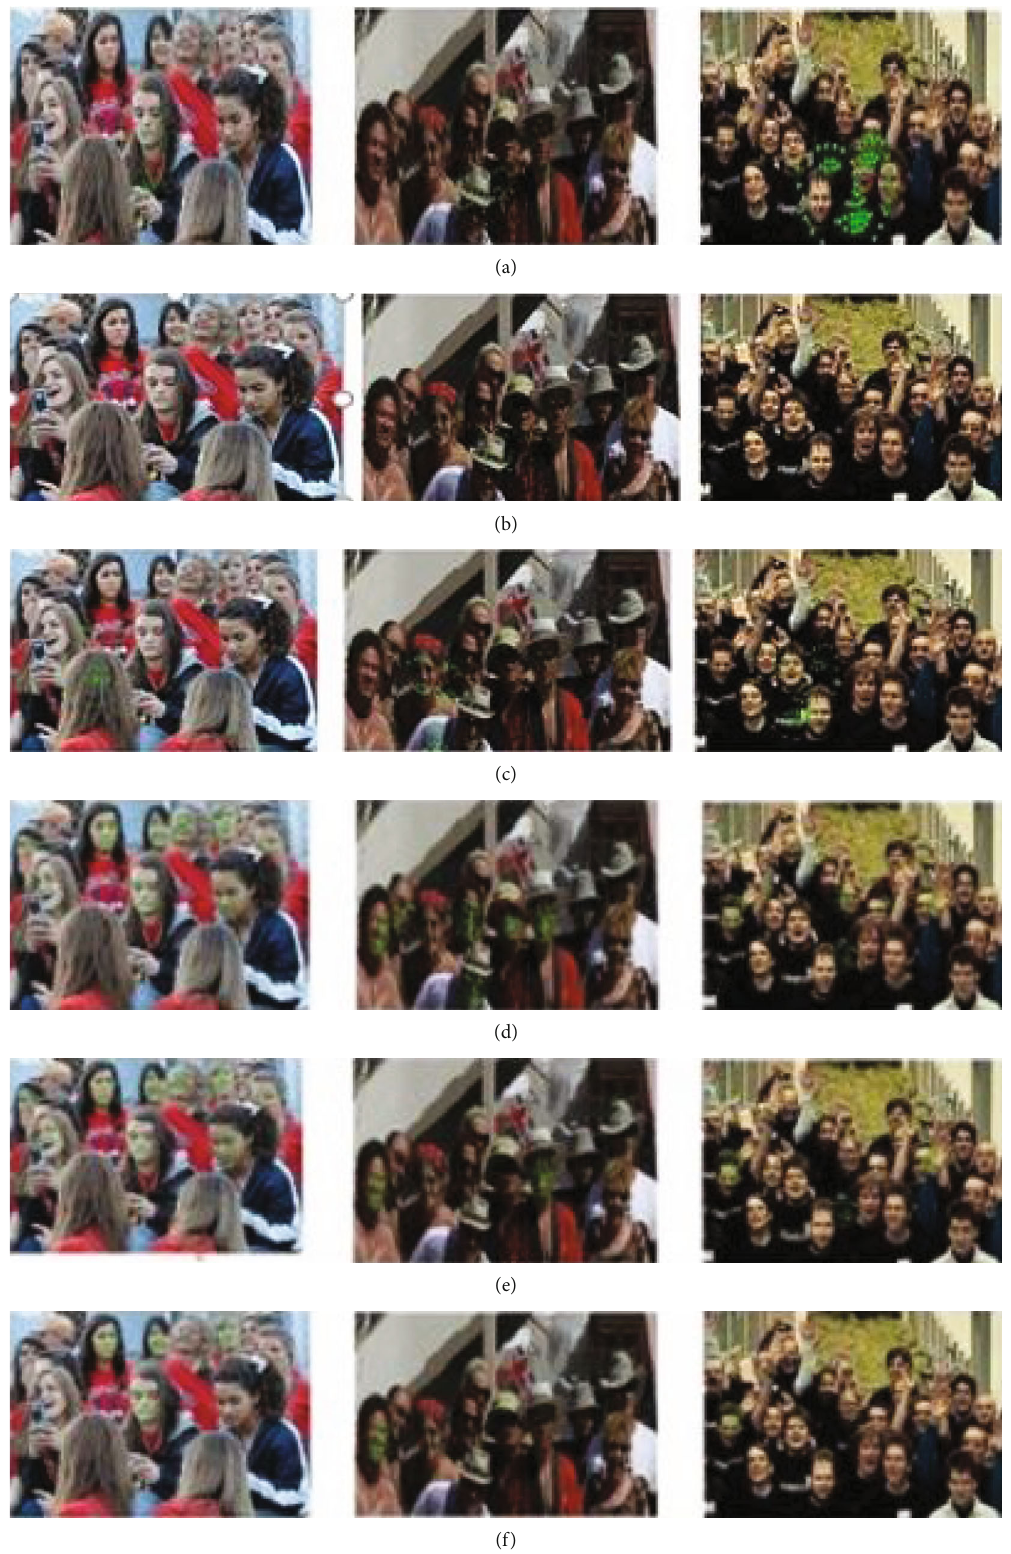
Figure 2: Performance evaluation of the proposed method via facial landmark localization on the HELEN68 dataset: (a) TCDCN, (b) RFLD, (c) Fast-SIC, (d) HPM, (e) UF-DD, and (f) ours. The red points indicate the key points which are predicted as being